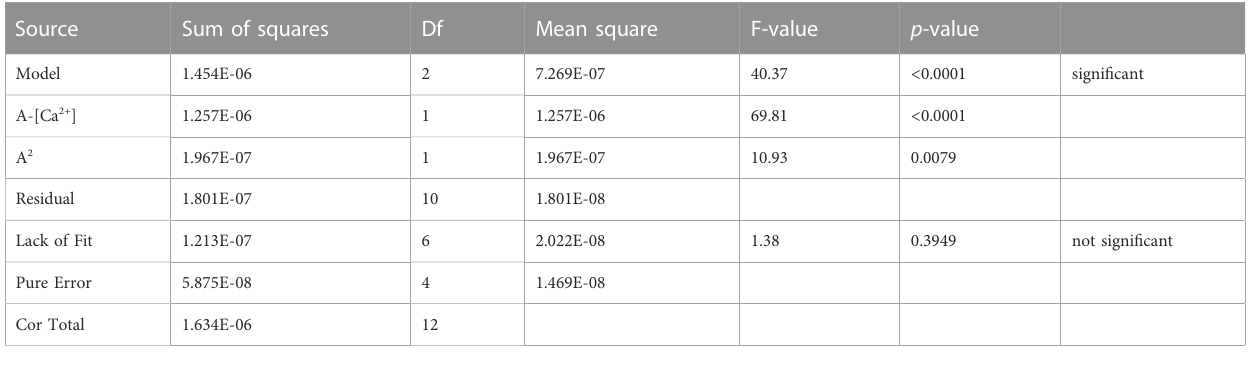
TABLE 10 ANOVA of the model for [Ca 2+ ]eq — [Ca 2+ ]plan.